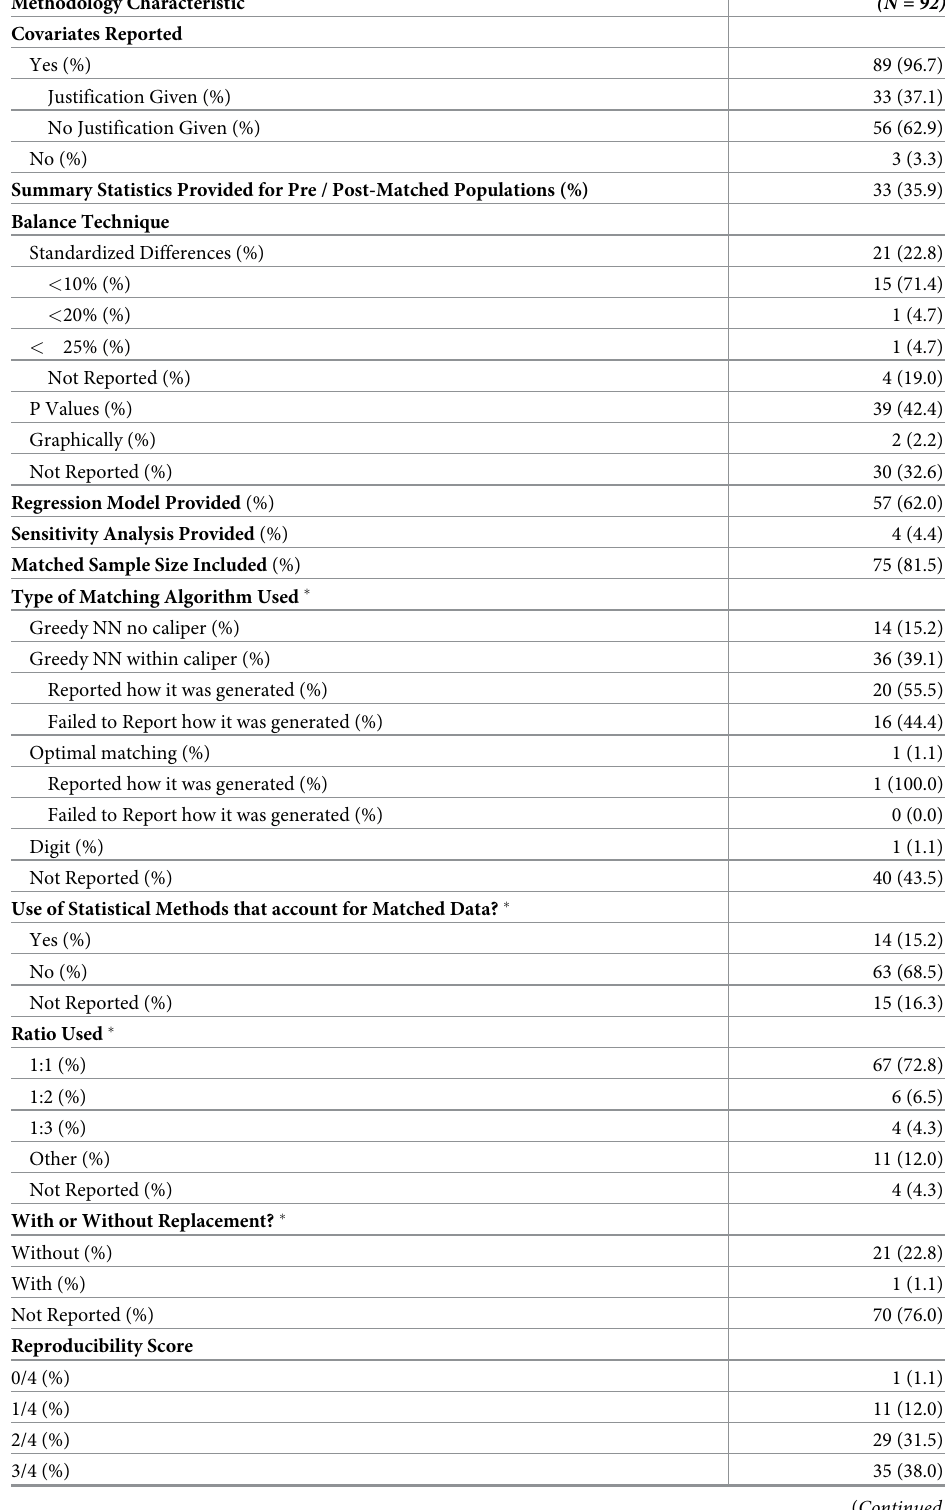
Table 3. Characteristics and quality of PSM reporting (n =